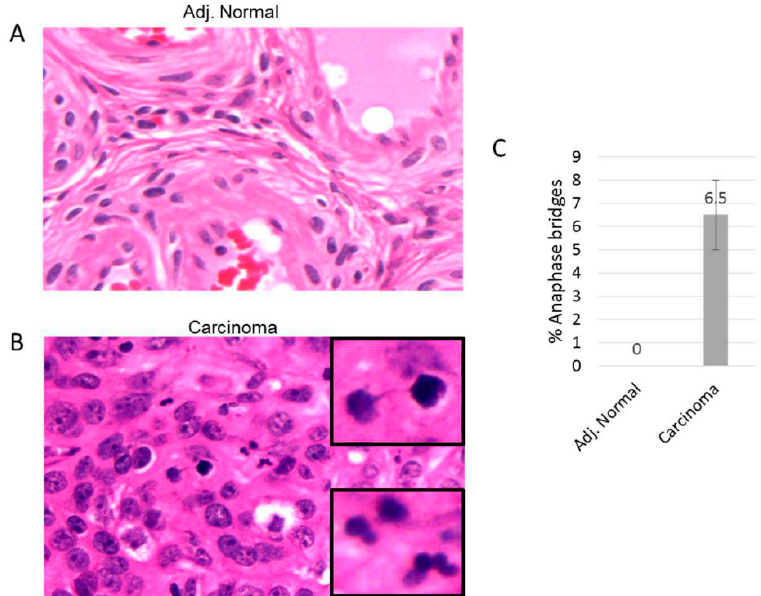
Figure 4. Anaphase bridge analysis in ovarian carcinoma. Tissue sections are stained with Hematoxylin and Eosin (H&E). ( A ) and ( B ) are representative adjacent tissue and ovarian carcinoma tissue sections, respectively. ( C ) The percent of anaphase bridges was calculated from the total anapases within each ovarian carcinoma.